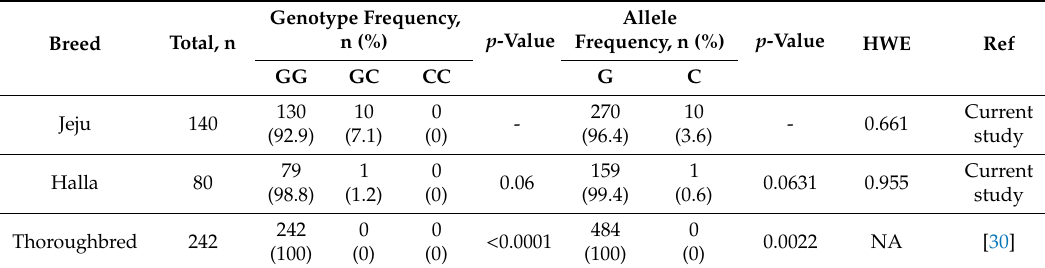
Table 2. Genotype and allele frequencies of the PRND c.411G > C polymorphism in Jeju, Halla, and Thoroughbred